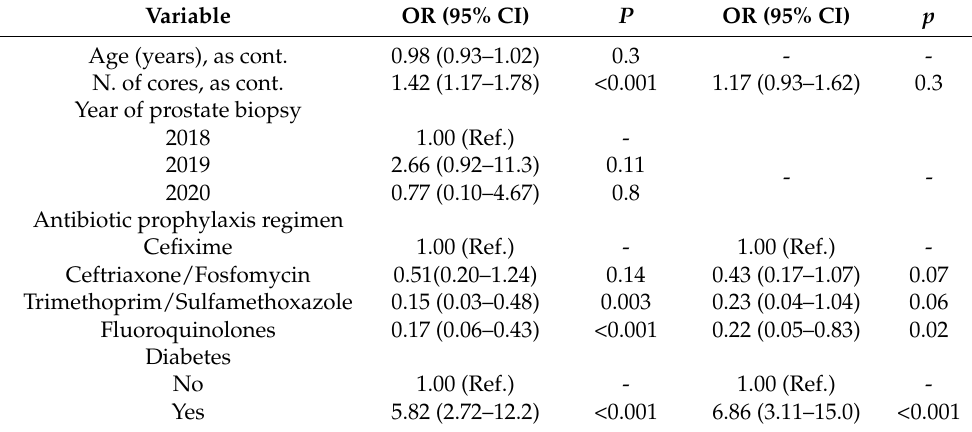
Table 3. Univariable and multivariable binomial logistic regression analysis for the prediction of infective complications among 1150 patients who underwent transrectal ultrasound prostate